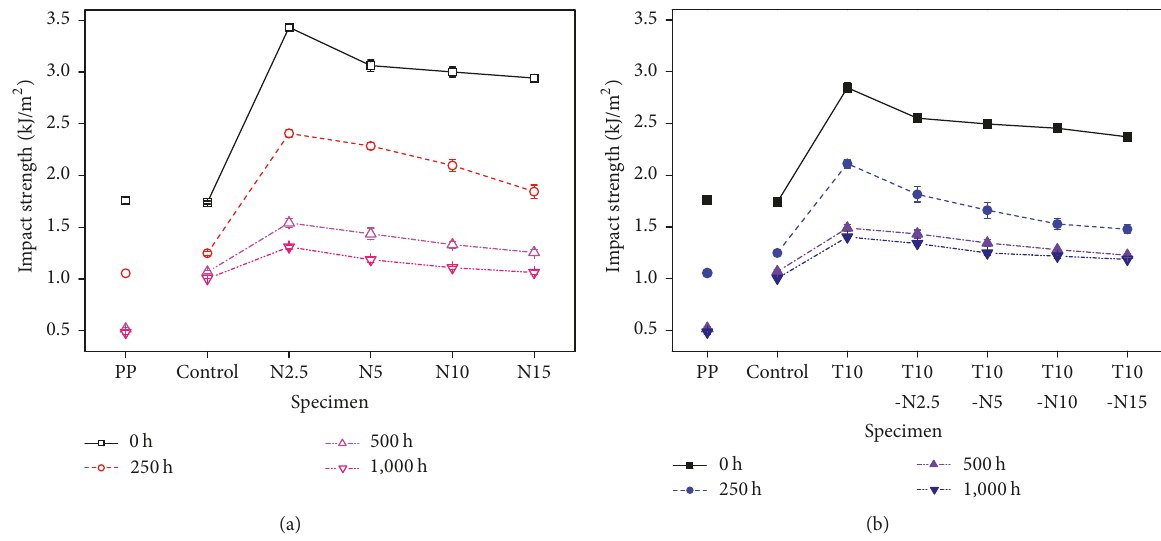
Figure 1: Impact strength of pure PP, control, and PP-based composites depending on accelerated weathering time: (a) NCC-only; (b) NCC-